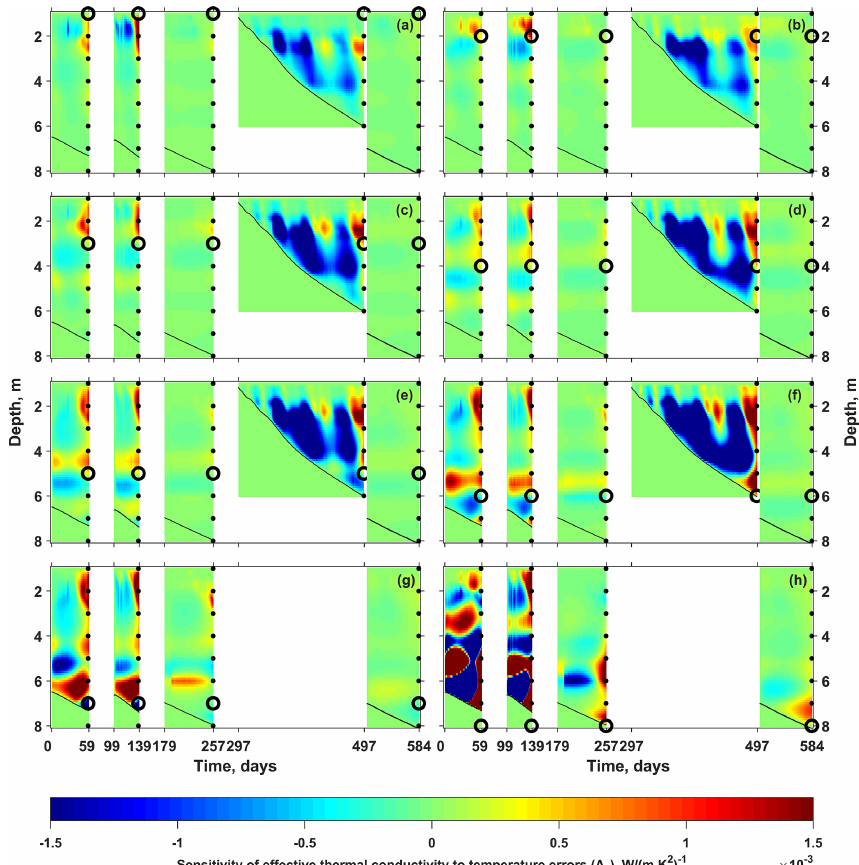
Figure 5. Sensitivity ( A τ in Eq. 15) of effective thermal conductivities ( k ∗ j ) to errors in the temperature measurements. Panels (a–h) correspond to j = 1 , 2 ,..., 8, in each case the depth of k ∗ j is highlighted by black circle; depths of other k ∗ values are shown by black dots. The colour at a certain point in depth and time corresponds to the feedback of the k ∗ j value found at the depth shown by the black circle to a unit error in temperature ( + 1 ◦ C) at that depth and time. Black curves indicate the lower boundaries of the computational domains; below them the sensitivity is set to 0. The horizontal axes are the same as in Fig.